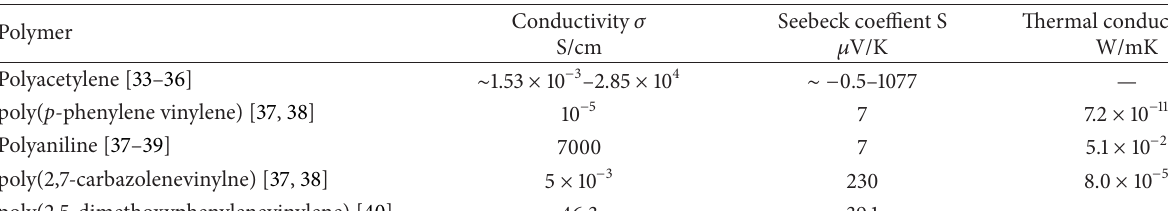
Table 1: Thermoelectric property of various polymers.